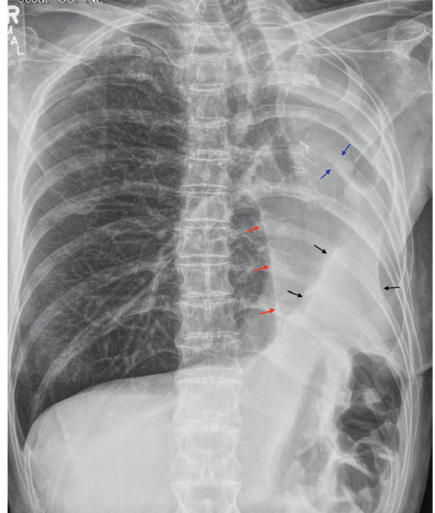
Figure 1: Anteroposterior chest radiograph demonstrates pneumonectomy surgical clips, suture, and left thoracostomy (blue arrows) with many secondary signs of left hemithorax volume loss including leftward tracheal shift, leftward shifting of the azygoesophageal recess (red arrows), upward tenting of the left hemidiaphragm (black arrows), and ipsilateral intercostal space narrowing.